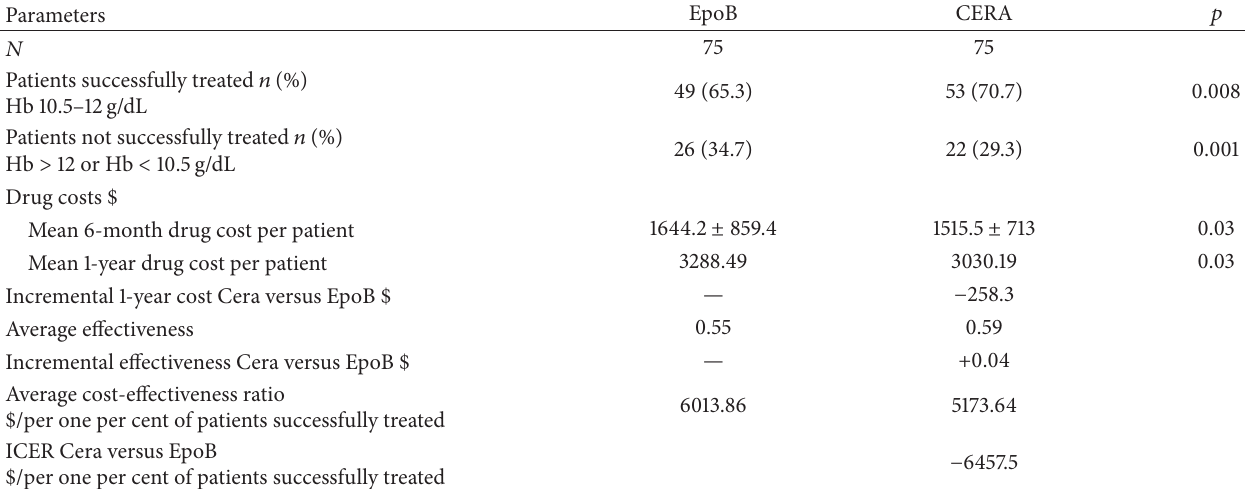
Table 3: Cost-effectiveness analysis of the study.